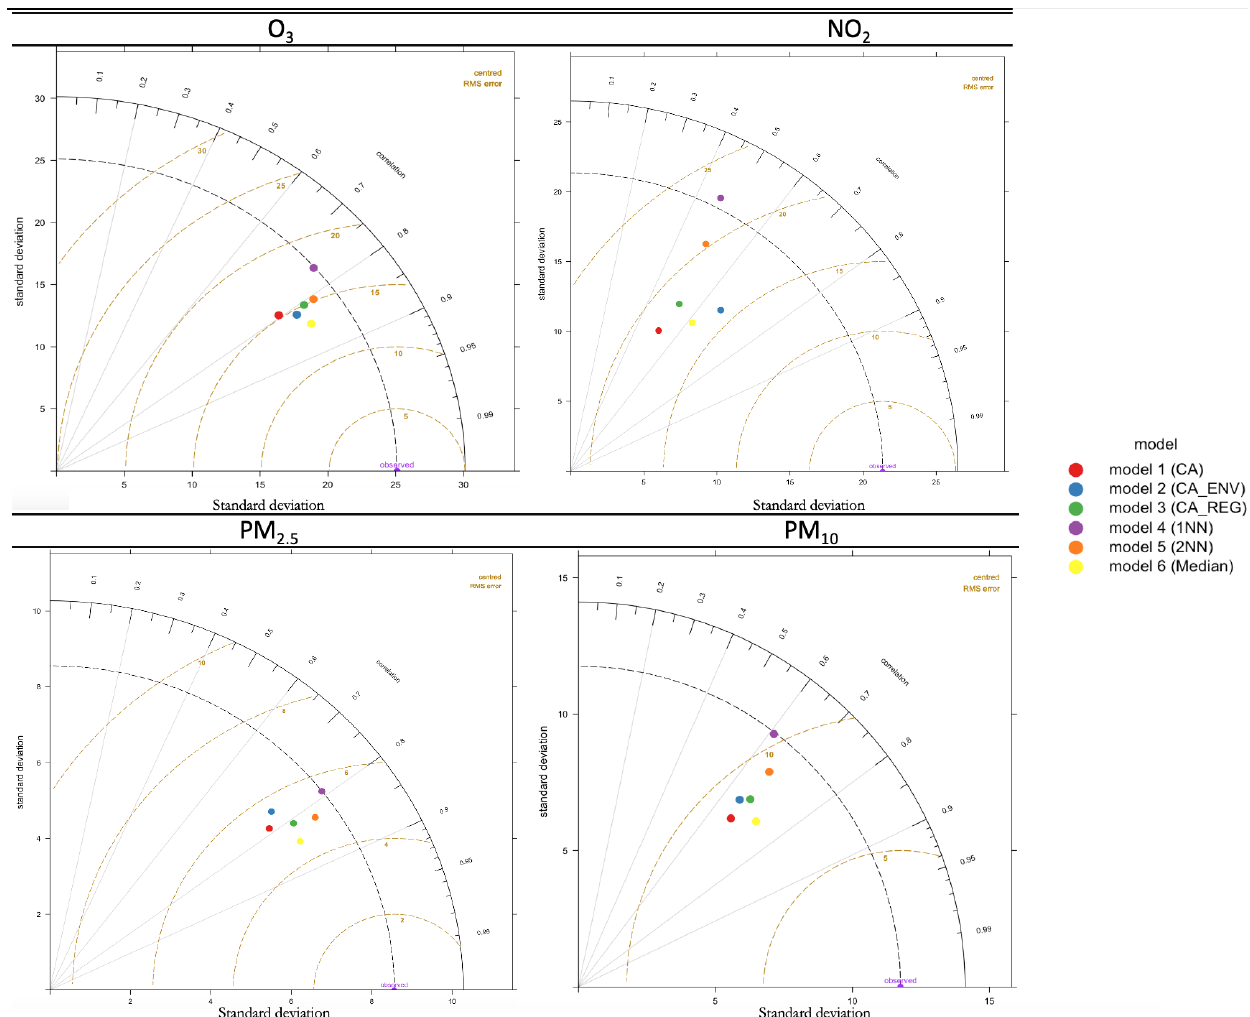
Figure 1. Taylor diagrams comparing modelled and observed concentrations for O 3 , NO 2 , PM 2 . 5 , and PM 10